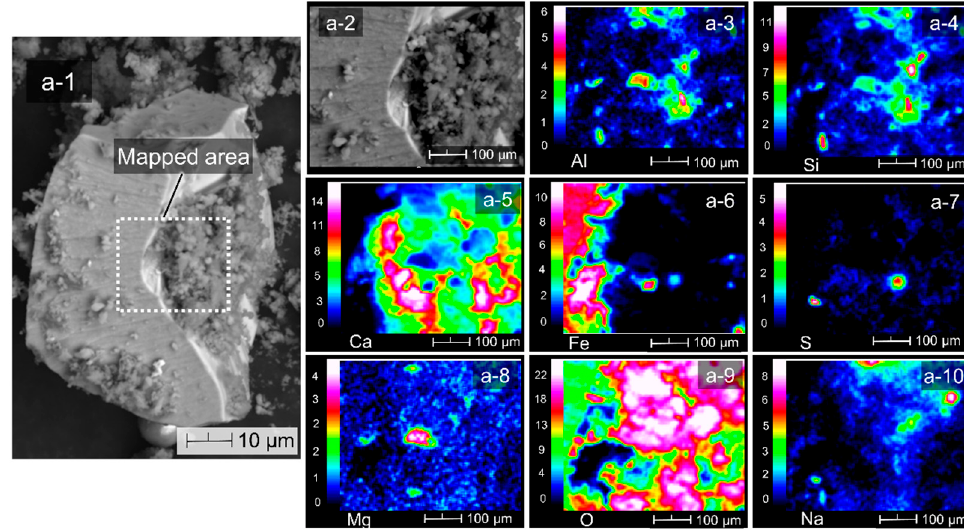
Figure 7. ( a-1 ) Photomicrograph of GPA and ( a-2 ) the mapped area with corresponding elemental maps of Al ( a-3 ), Si ( a-4 ), Ca ( a-5 ), Fe ( a-6 ), S ( a-7 ), Mg ( a-8 ), O ( a-9 ) and Na ( a-10 ).